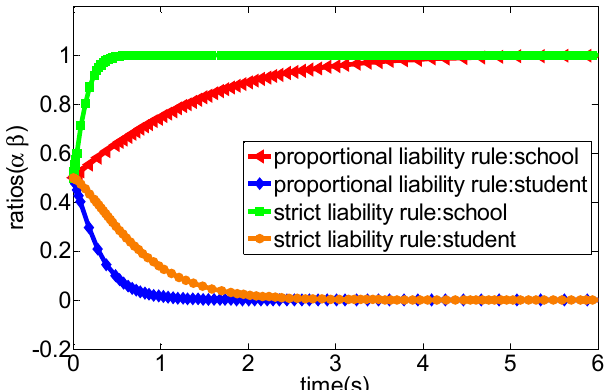
Figure 6. The evolution process of the system game strategy under the condition of low prevention cost from school and high accident loss (case 5).